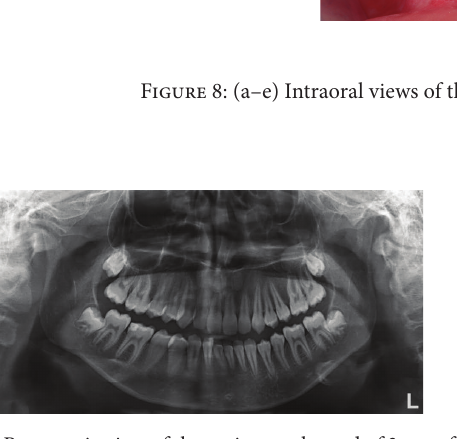
Figure 9: Panoramic view of the patient at the end of 3-year follow- up. Figure 10: Panoramic radiograph of the patient’s brother showing impacted supernumerary